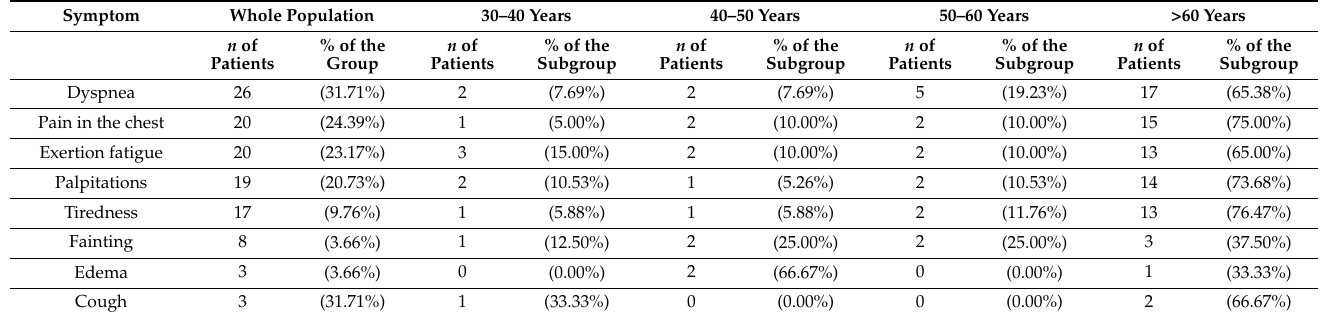
Table 2. Symptoms reported by the patients during the diagnostic process. Data are additionally stratified by age and presented as the number of patients with a percentage of the whole population or a particular subgroup.